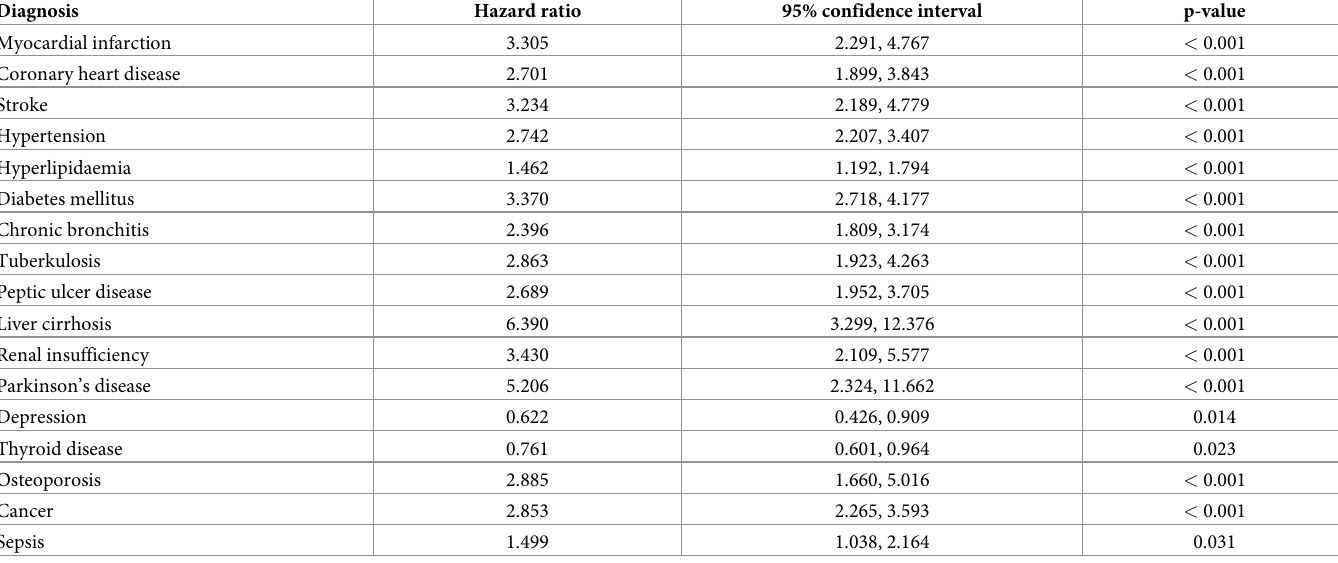
Table 3. Relation between single diagnoses and survival time for diagnoses with significant relations according to univariate analysis (p-value < 0.05).